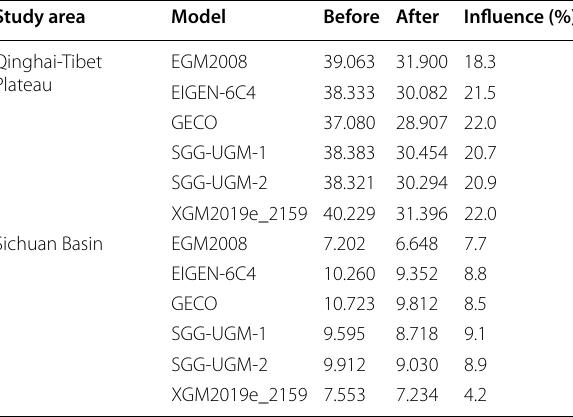
Table 6 The precision improvements obtained by terrain correction for each gravity field model (unit: